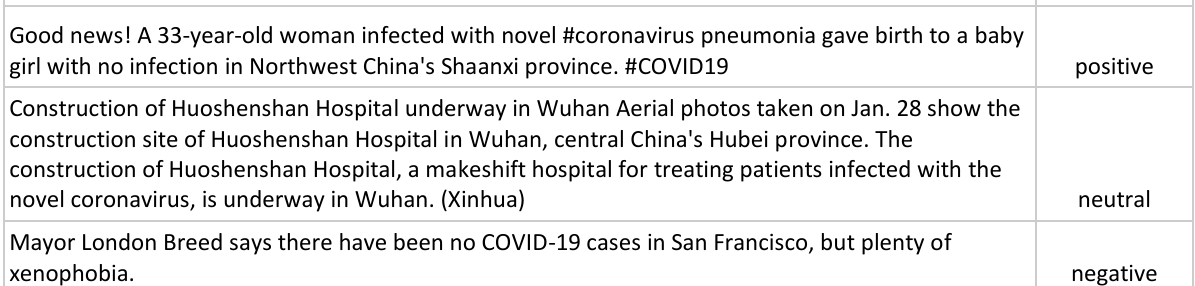
Table 2 : U.S. mainstream outlets